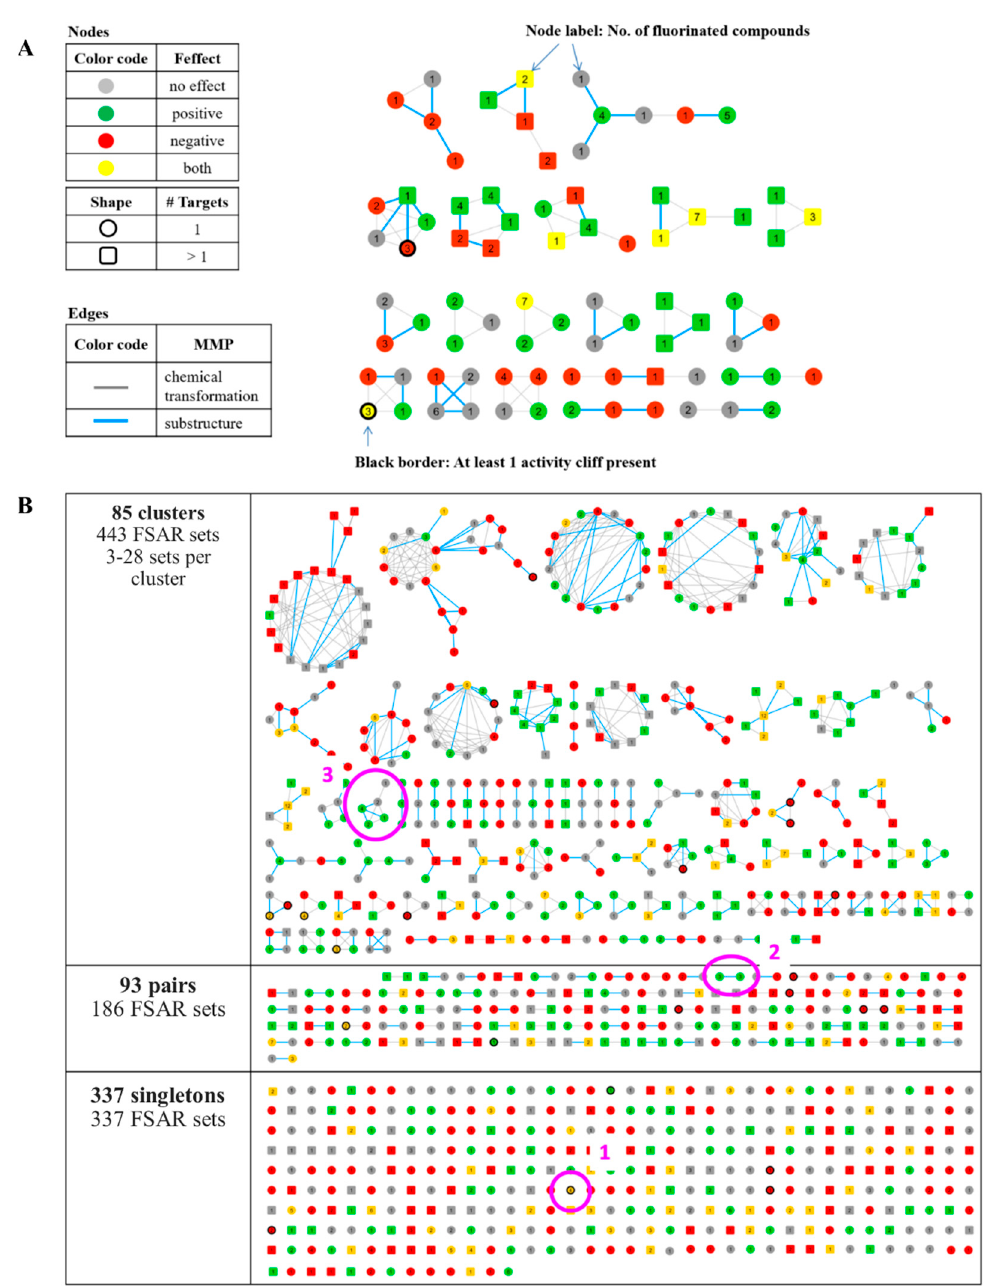
Figure 5. MMP networks. ( A ) The schematic depicts different information layers contained in the network. Nodes (non-F ligand and the corresponding FSAR set) and node shape account for single- (circle) or multi-target (square) activity. The color of the node represents the potency effect (green: positive, red: negative, yellow: both, and grey: no effect). Edges between nodes are drawn if the corresponding compounds form MMPs (grey). If one of the nodes is a substructure of the other, the edge is colored in blue. A thick black node border indicates the presence of at least one AC in the FSAR set. ( B ) The network for all 966 FSAR sets is shown. At the top, 85 complex clusters are formed between 3 to 28 FSAR sets. In the middle, FSAR set pairs, formed by two FSAR sets, and at the bottom 337 FSAR sets with no structural neighbors are shown. Exemplary clusters (1, 2, and 3) are encircled in pink and shown in detail in Figure 6 (A, B, and C, respectively).